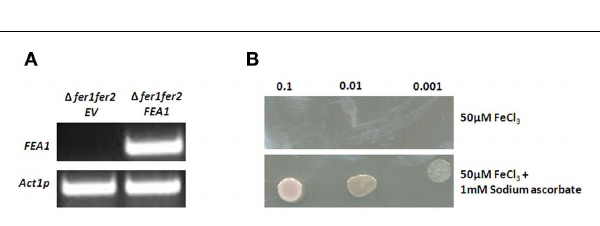
FIGURE 8 | FEA1 protein facilitates uptake of ferrous iron in yeast .The yeast ferric reductase ( Δ fer1fer2) mutant was transformed with the pESC–LEU–FEA1 vector. (A) RT-PCR expression of FEA1 transgenic yeast. Actin was used as an internal expression control. (B) Growth of yeast on synthetic defined SG-LEU media containing 50 μ M FeCl 3 or SG-LEU media containing 50 μ M FeCl 3 + 1mM sodium ascorbate. Plates were grown at 28˚C for